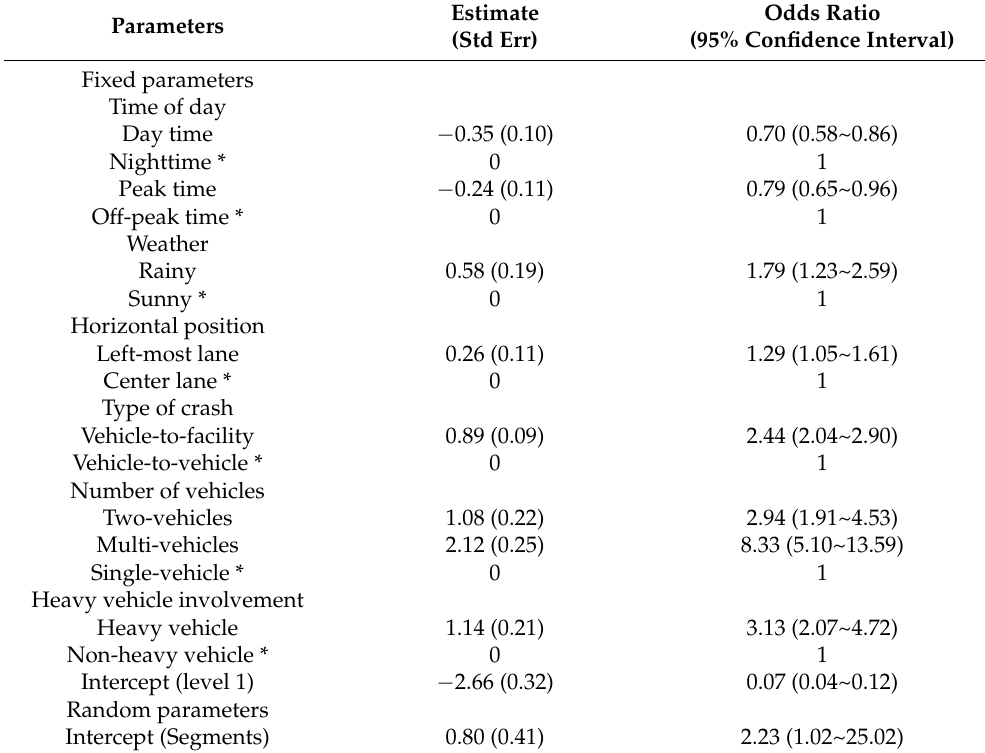
Table 3. Estimation results for crashes on two-way ten-lane freeways.